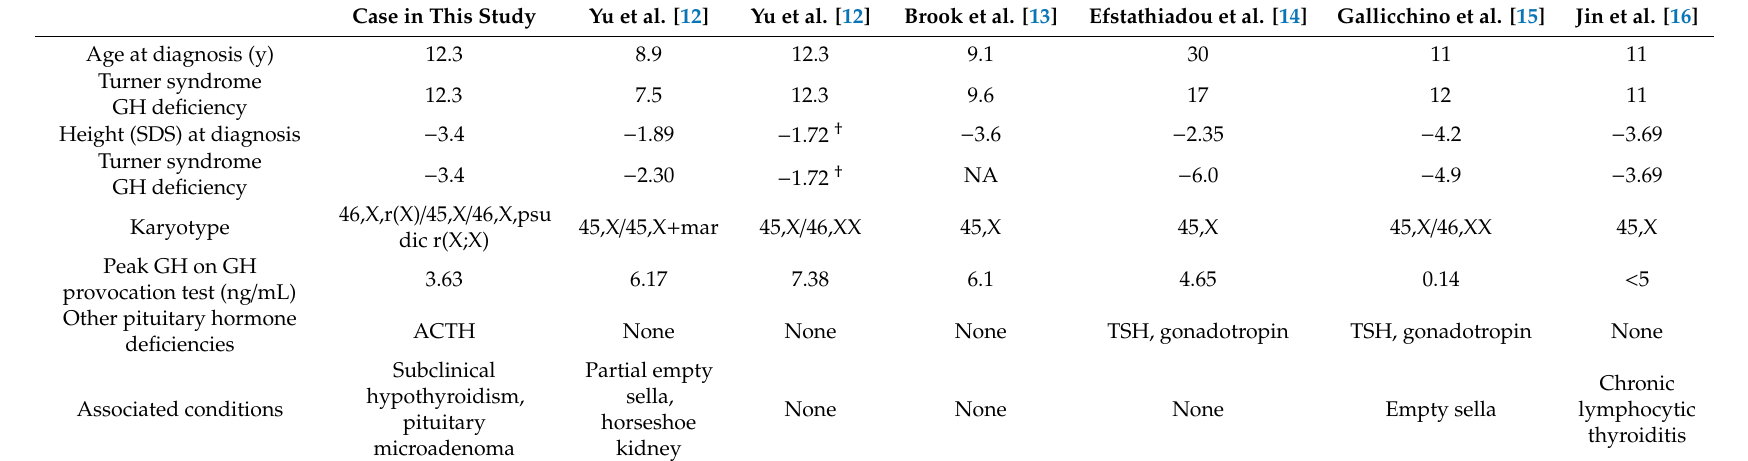
Table 1. Comparison of clinical and laboratory features between this case and previously reported cases of TS associated with GH deficiency.